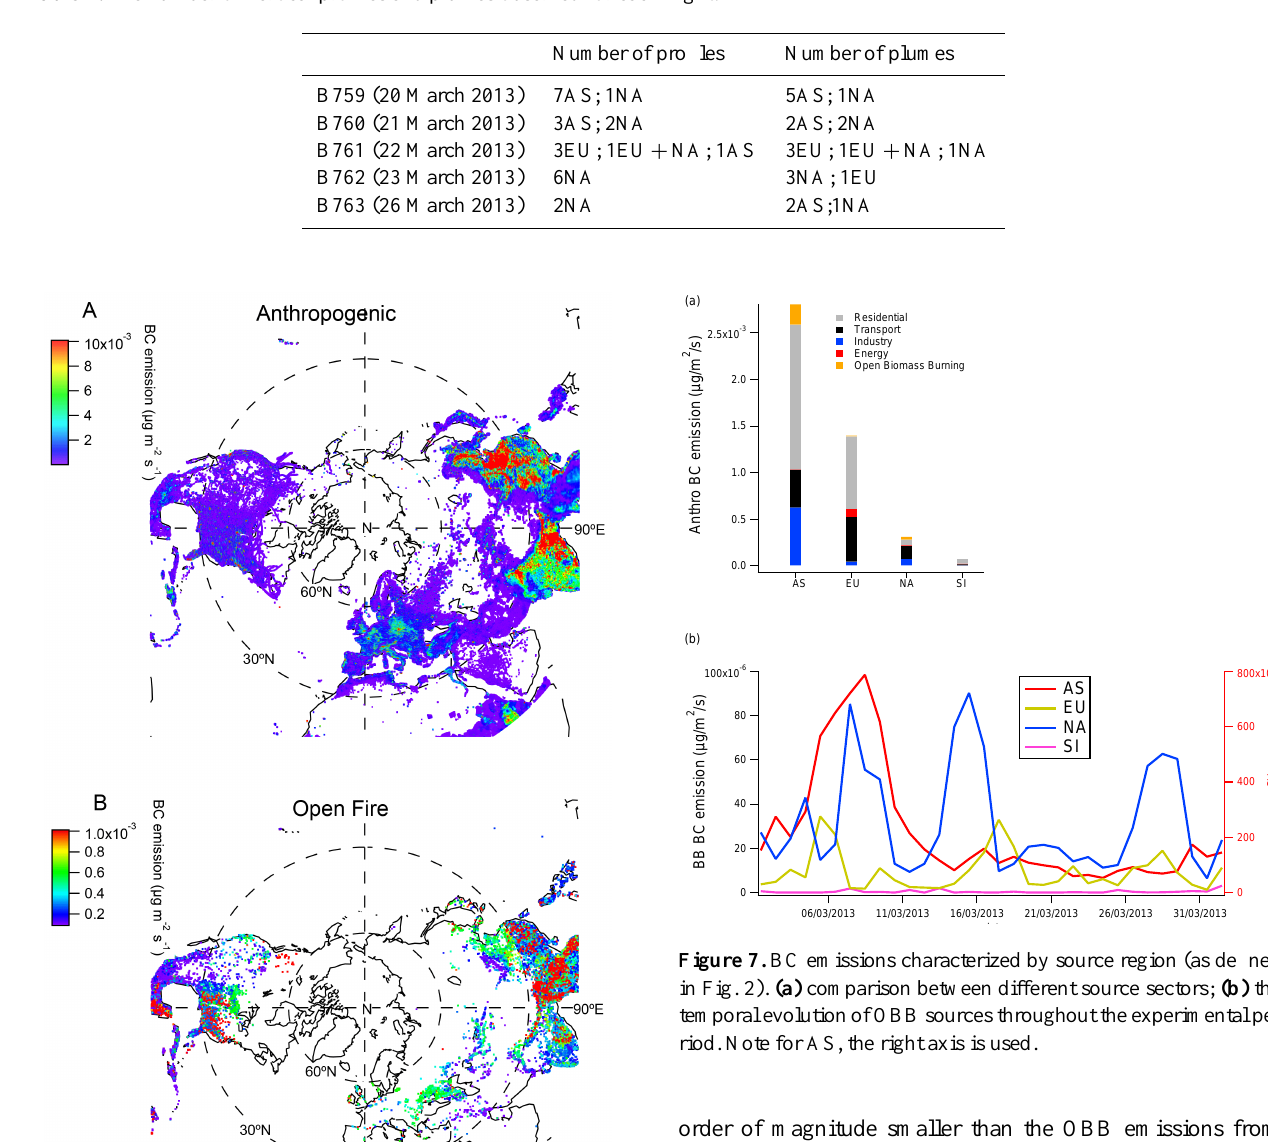
Table 1. The number of vertical profiles and plumes observed for each flight.